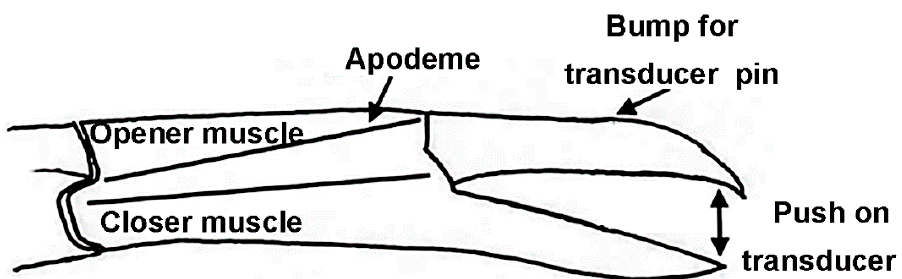
Figure 1. Side view of the chelated first walking leg. pushing on the transducer pin resting on the top of the dactylopodite. This side view shows the location of the apodemes for opener and closer muscles in the propodite. The force transducer pin rests on the bump on the dactylopodite. After inducing the crayfish to autotomize the walking leg by forcibly pinching the ischiopodite segment, a window was cut in the meropodite cuticle to expose the nerve of the opener muscle, and then, a window was cut in the propodite cuticle on the dorsal side.